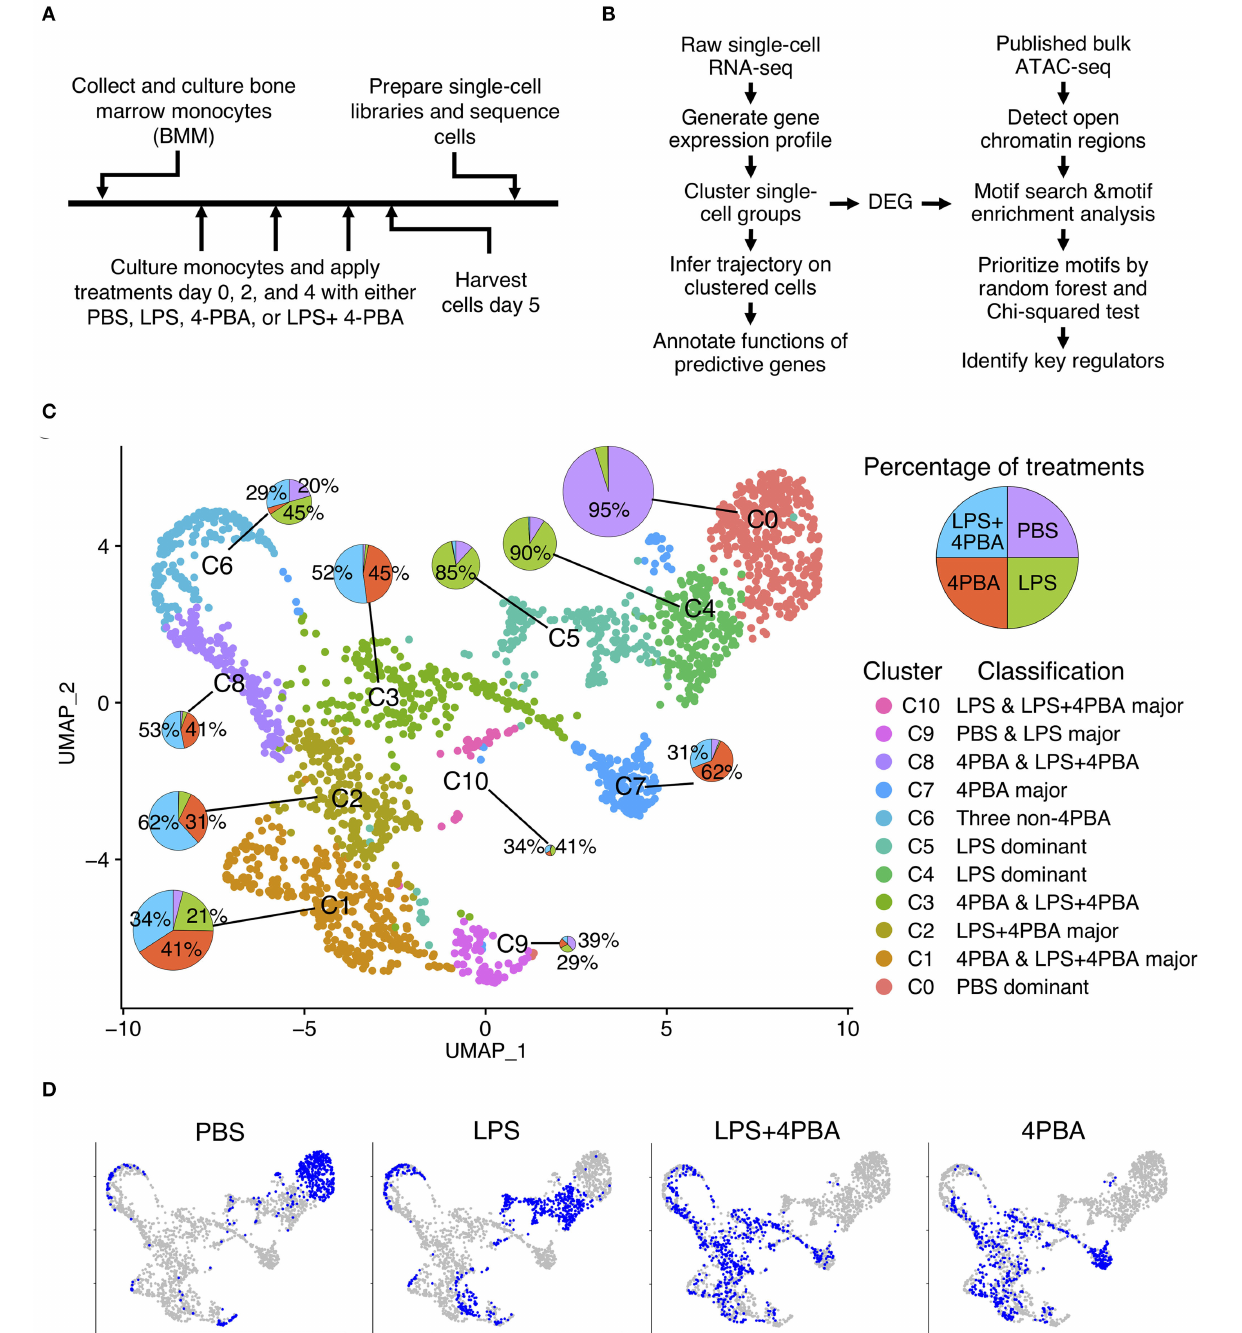
reads per gene per cell is 24 for our data (mean sequencing read pairs divided by the estimated number of cells and the median genes per cell, see Supplementary Table 1 ).